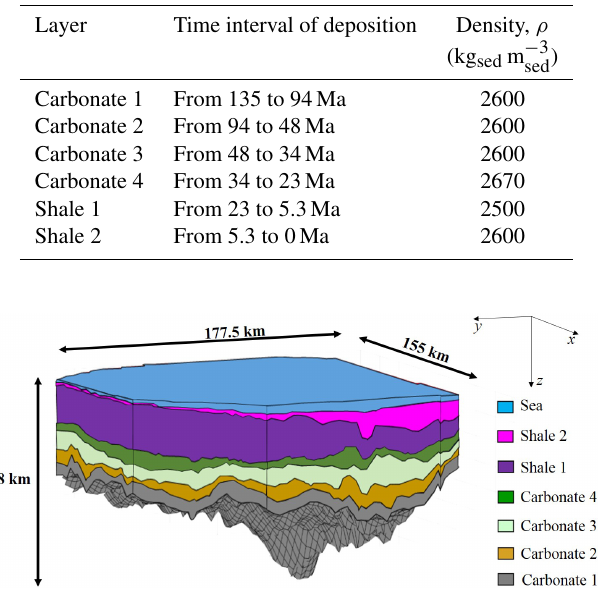
Table 1. Sequence of sediments deposited during the 135Ma of basin deposition history and sediment density.